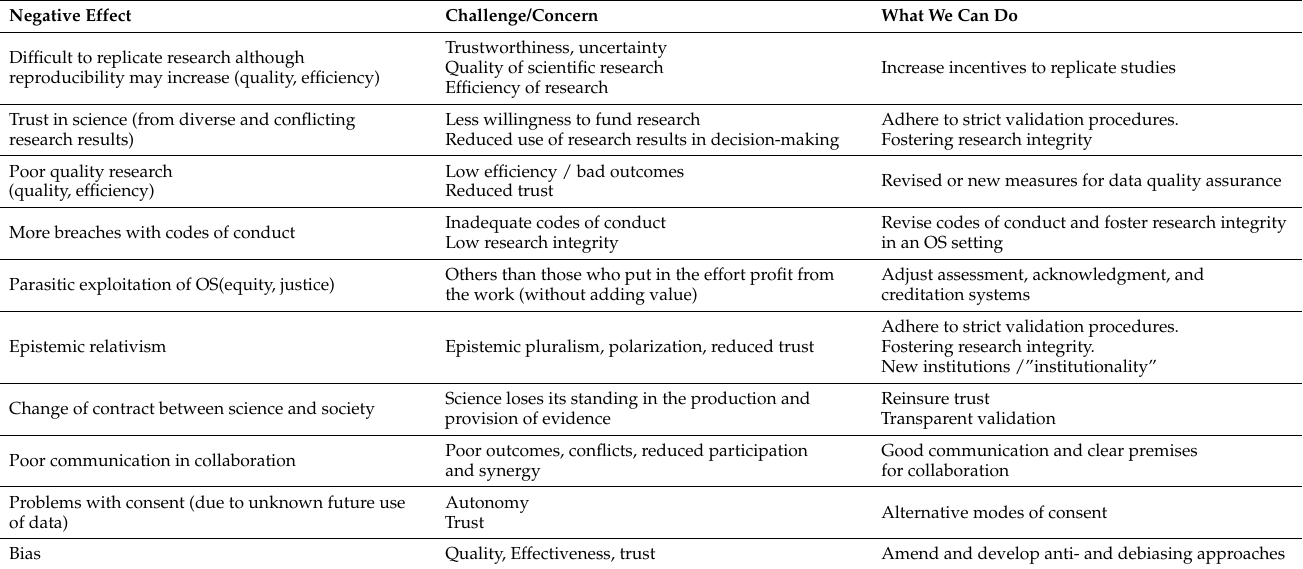
Table 3. Overview of concerns with potential negative effects of OS identified in the literature and suggestions for measures to address